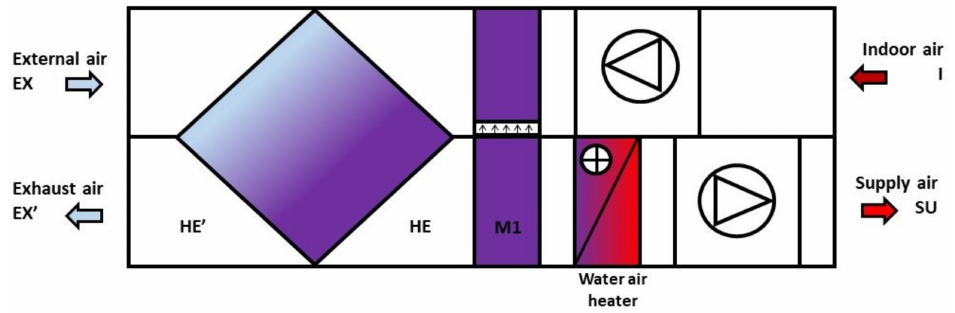
Figure 1. Swimming pool ventilation unit with heat recovery recuperator and water heater [23]: SU—supply air parameters, I—indoor air parameters, EX—external air parameters, M1—air